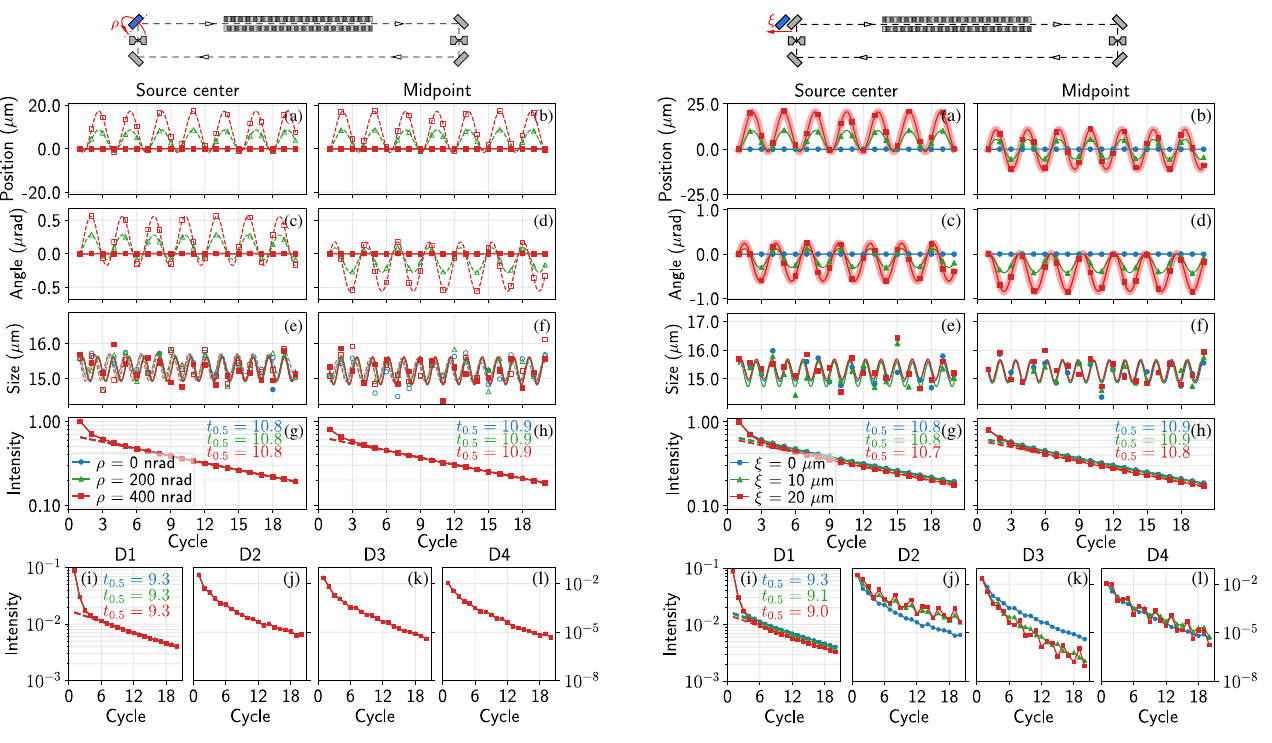
FIG. 16. Similar to Fig. 14, but with position error ξ in crystal C 4